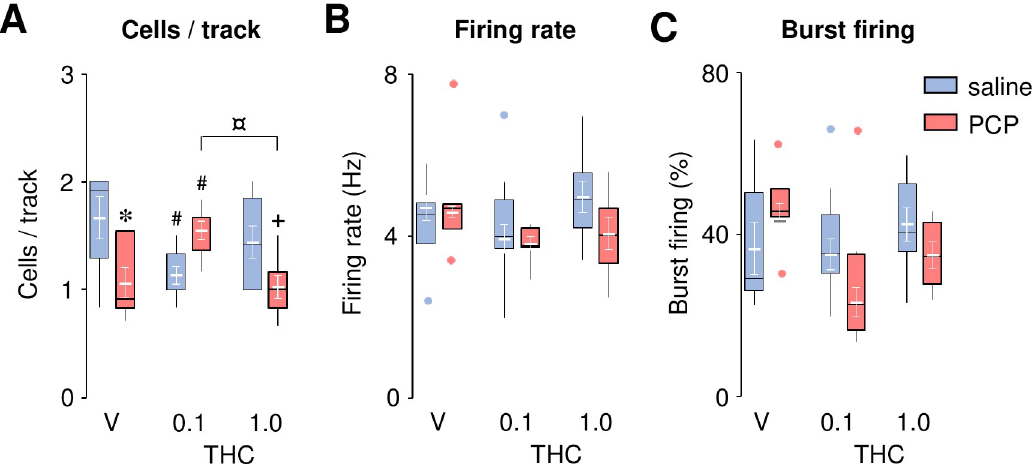
Fig 4. THC reversed PCP-induced decrease in dopamine neuron population activity in the VTA. Effects of THC (0.1 and 1.0 mg/kg) on the number of spontaneously active cells per track ( A ), average firing rate ( B ) and average burst firing ( C ) in saline- and PCP- treated rats. The raw data for this figure are reported in the supplemental file (S1 Raw data) and are summarized here as boxplots computed using Carling’s modification [42]; outliers are depicted as blue (saline) or red (PCP) circles. Values (in white) are expressed as mean ± S.E.M. (n = 6–9 per group). � P < 0.05 compared to saline-treated controls, # P � 0.05 compared to vehicle (V) controls, + P < 0.05 compared to saline-treated vehicle (V) controls, ¤ P < 0.05 (Newman-Keuls post-hoc